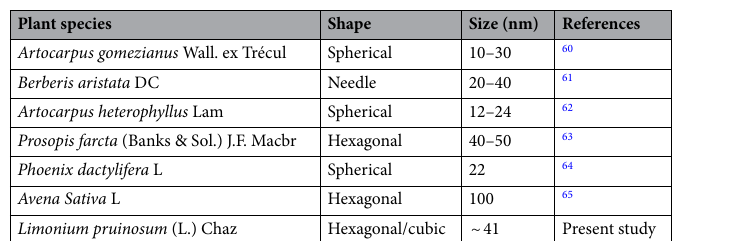
Table 2. Comparison of biosynthesized ZnO NPs using different plant species.